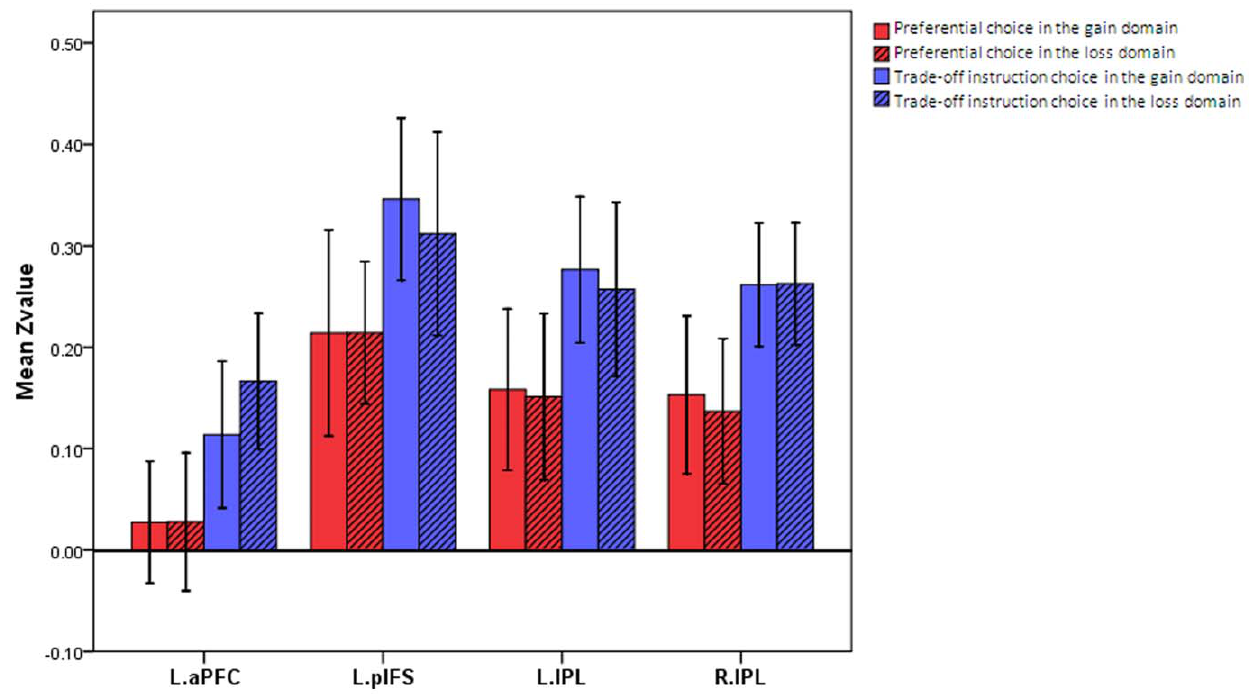
Figure 4. Mean correlation coefficients in the regions in the probability network showing differences in connectivity with the payoff network. Abbreviations: see Table 1.